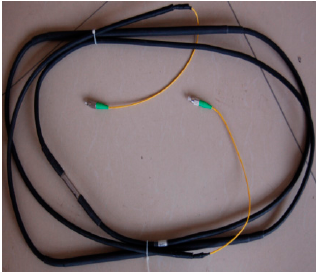
Figure 9. A packaged FBG temperature sensor.